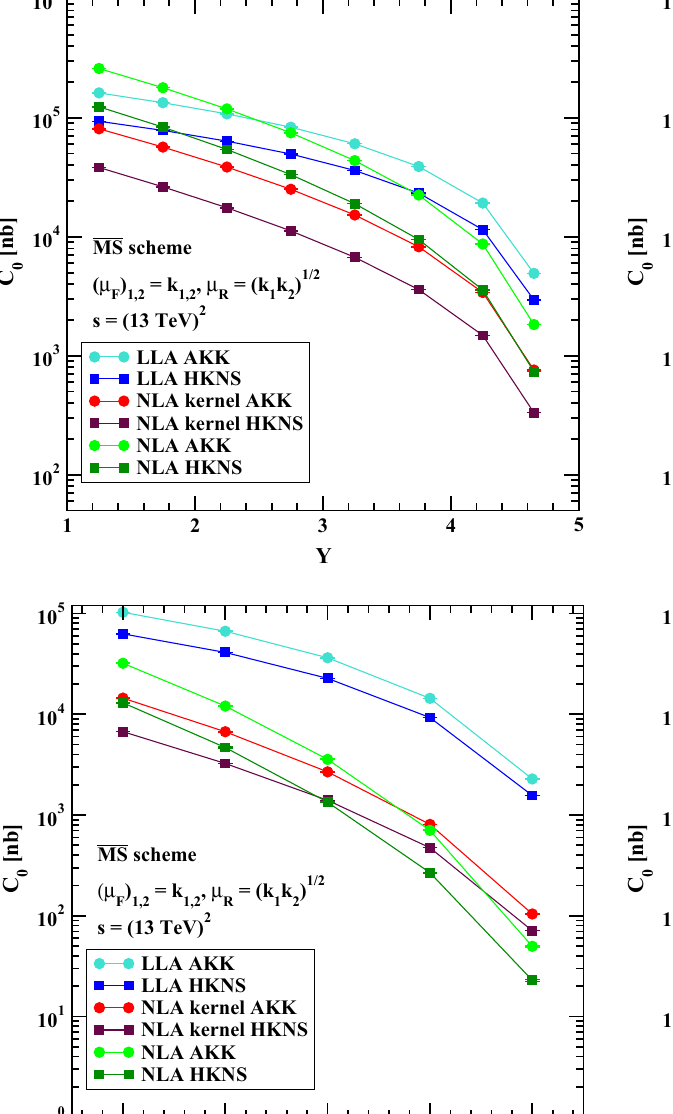
√ s = 7 , 13 TeV, and in